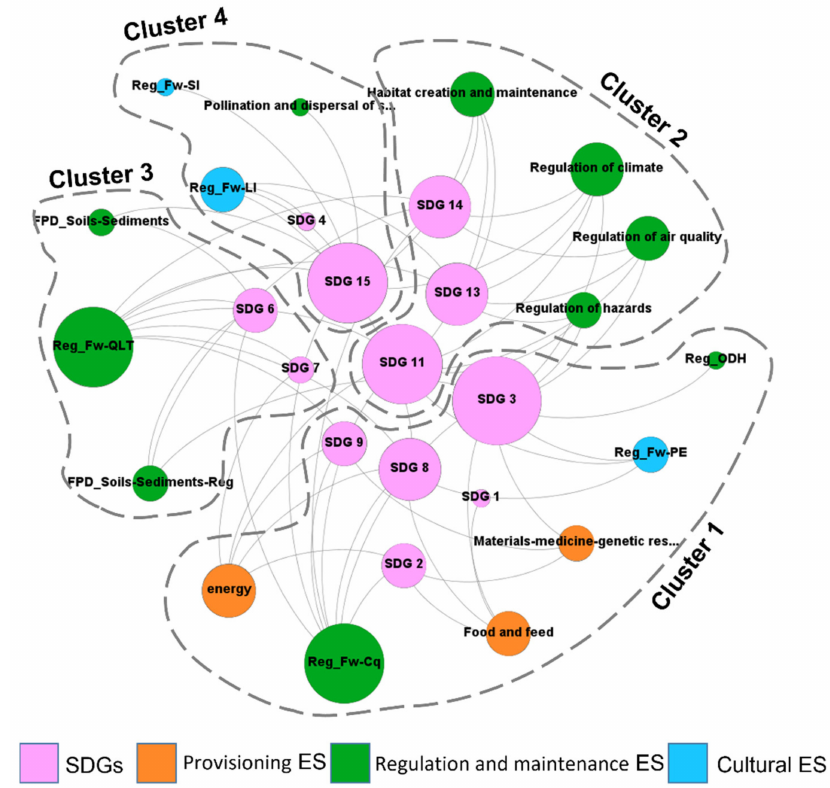
Figure 10. Conformation of clusters between ES and